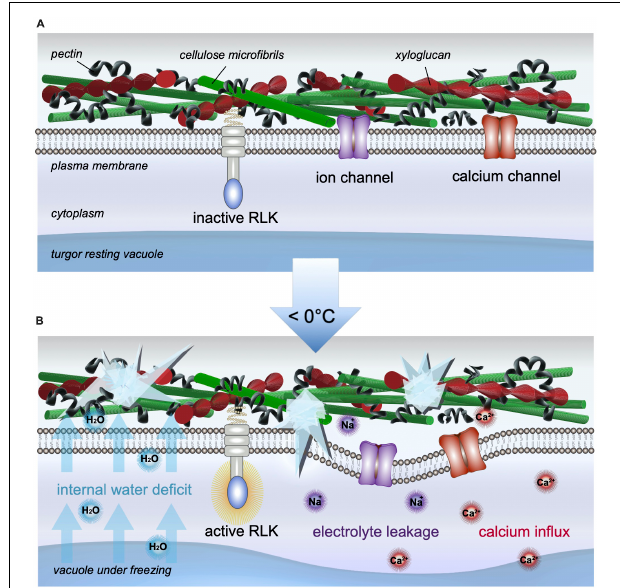
FIGURE 2 | Cellular changes induced by freezing stress. (A) At ambient temperatures, the cell wall and membrane, as well as other cellular compartments, are intact and the cell is in a normal resting state, which ensures water and cellular volume homeostasis. (B) In the event of freezing stress, ice formation in the apoplast induces a movement of water out of the cell, which results in an internal water deficit, mimicking dehydration. If exposure is prolonged, intracellular ice may form, rupturing the plasma membrane, causing activation of RLKs, electrolyte leakage, calcium influx, and cell death, when the membrane eventually pulls away from the cell